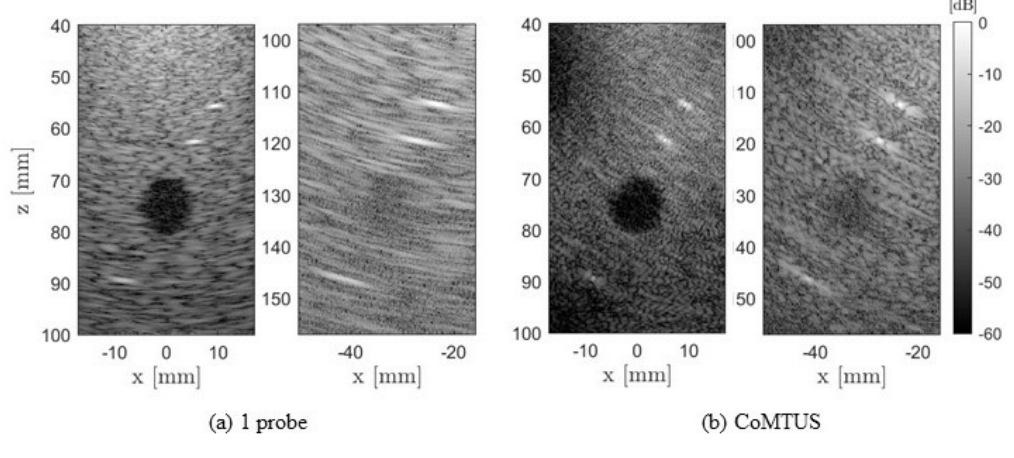
Figure 7. Comparison of simulated images of the non-aberrating medium at different imaging depths acquired by ( a ) one probe and ( b ) CoMTUS.